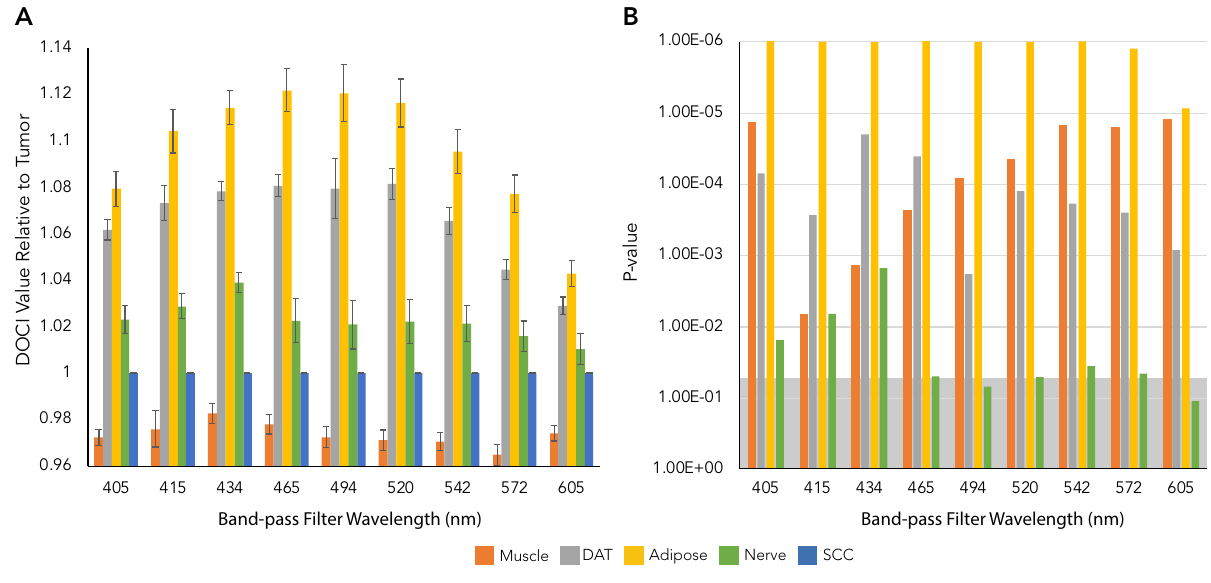
Figure 2. Relative lifetimes of healthy and malignant tissue. ( A ) Average relative lifetimes (DOCI values) of different tissue types as a function of wavelength (n = 15). ( B ) Manhattan plot of P values for DOCI values of each tissue type compared to HNSCC across all wavelengths. Significance is defined as P < 0.05. The significance threshold is denoted in gray and all bars above the threshold are considered significant.